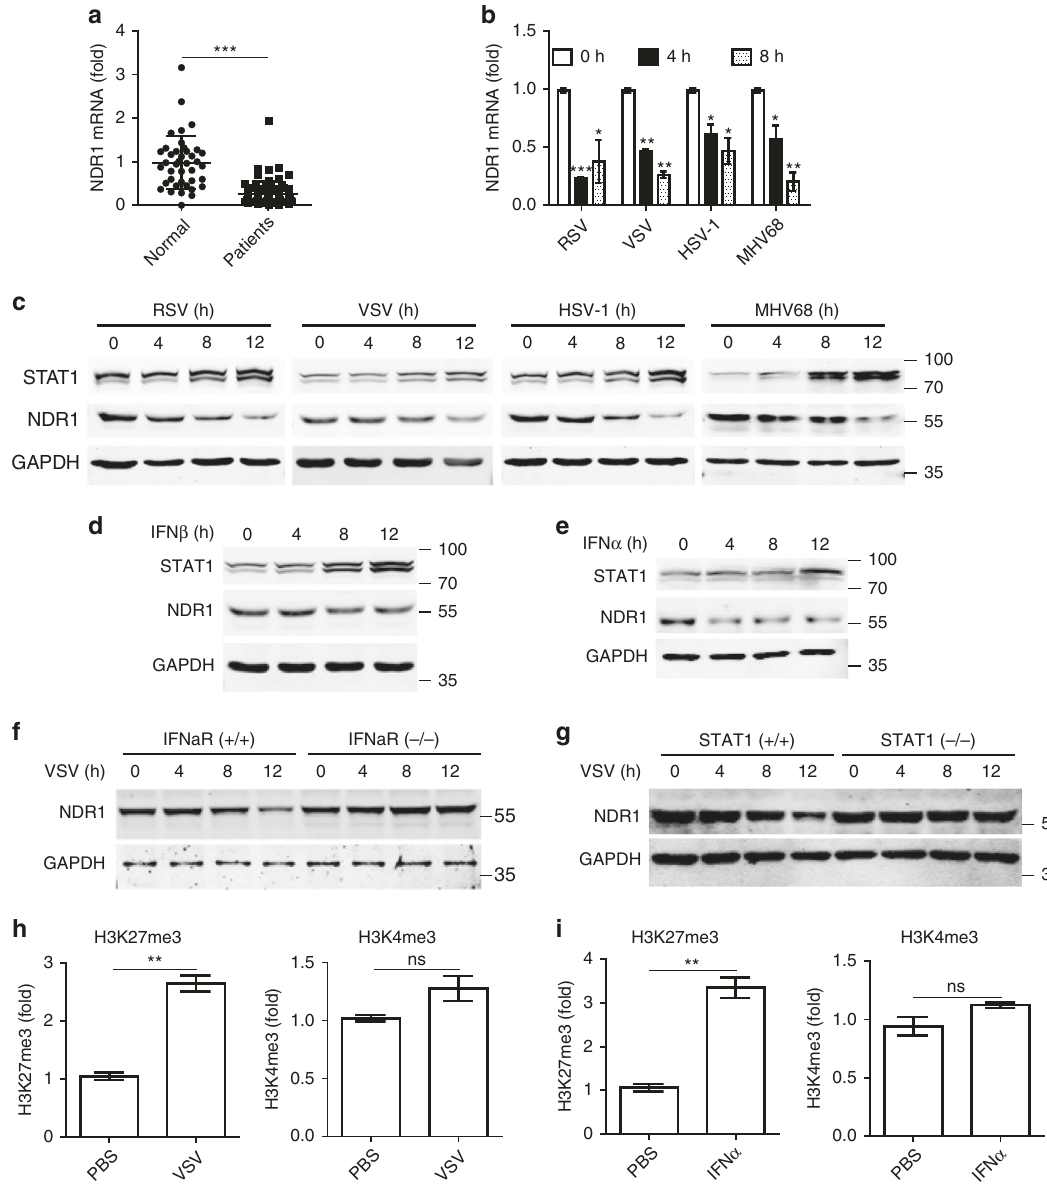
Fig. 1 Viral infection downregulates NDR1 expression in a type I IFN pathway-dependent manner. a Real-time PCR analysis of NDR1 mRNA in the peripheral blood from patients infected with RSV ( n = 77) and healthy control ( n = 40). b , c Real-time PCR ( b ) and immunoblot analysis ( c ) of NDR1 expression in peritoneal macrophages (PMs) infected with RSV, VSV, HSV, or MHV68. d , e Immunoblot analysis of NDR1 expression in PMs treated with IFN β (100 IU ml − 1 ) (d) , or with IFN α (100 IU ml − 1 ) ( e ). f , g Immunoblot analysis of NDR1 expression in lysates of IFN α R + / + and IFN α R − / − ( f ) or STAT1 + / + and STAT1 − / − ( g ) mouse immortalized bone marrow-derived macrophages infected with VSV. h , i ChIP-qPCR analysis of the histone modi fi cation in NDR1 promoter with H3K27me3 and H3K4me3 antibodies in lysates of Thp1 cells treated with VSV for 8 h ( h ) or with IFN α (100 IU ml − 1 ) for 4 h ( i ). Data are mean ± SD and are representative of three independent experiments. Student ’ s t test was used for statistical calculation. * p < 0.05, ** p < 0.01, *** p < 0.001. See also Supplementary Fig. 1